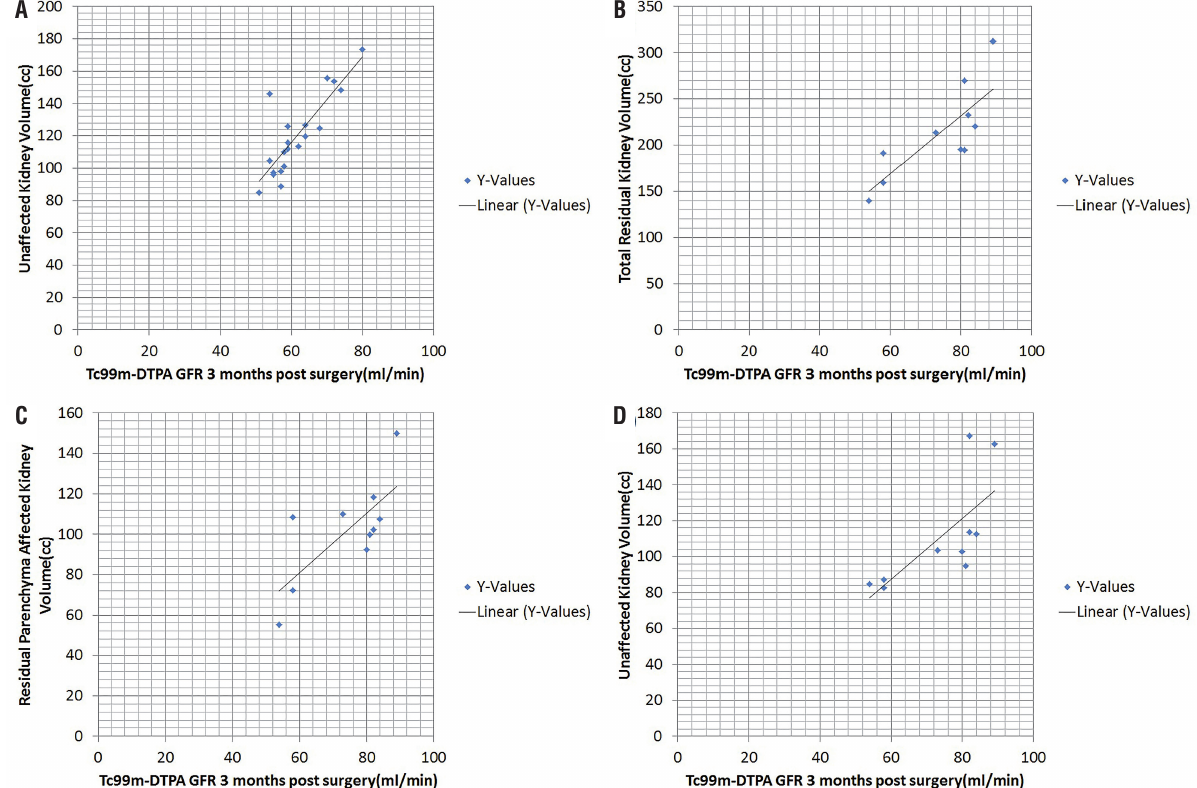
Figure 2 - Correlation analysis of (A) GFR and unaffected kidney volume on imaging 3 months after radical nephrectomy surgery, (B) GFR and total residual kidney volume (affected+unaffected kidney) on imaging 3 months after Nephron sparing surgery, (C) GFR and residual parenchyma affected kidney volume on imaging 3 months after Nephron sparing surgery, and (D) GFR and unaffected kidney volume on imaging 3 months after nephron sparing surgery.